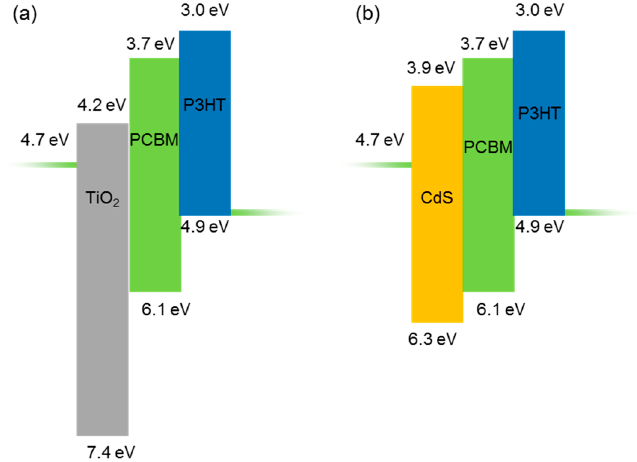
Figure 5. The J-V measurements of P3HT:PCBM solar cells with TiO 2 and CdS thin film as HBL with respective optimum thicknesses.